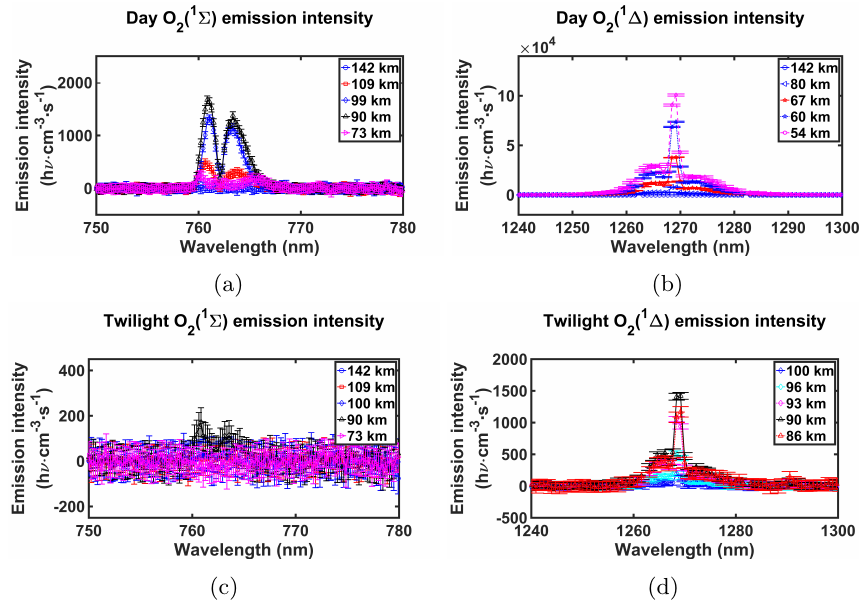
Figure 4. Examples of the emission intensities that are obtained by solving Eq. (3). (a) For the daytime O 2 ( 1 (cid:54)) band on the date 3 Febru- ary 2010; orbit number 41455; mean latitude of 17.3 ◦ N, mean longitude of 94.3 ◦ E. (b) as (a) but for the O 2 ( 1 (cid:49)) band. (c) For the twilight O 2 ( 1 (cid:54)) band on the date 3 February 2010; orbit number 41455; mean latitude 78.0 ◦ N, mean longitude 226.5 ◦ E. (d) as (c) but for the O 2 ( 1 (cid:49)) band. Error bars represent the retrieval errors.